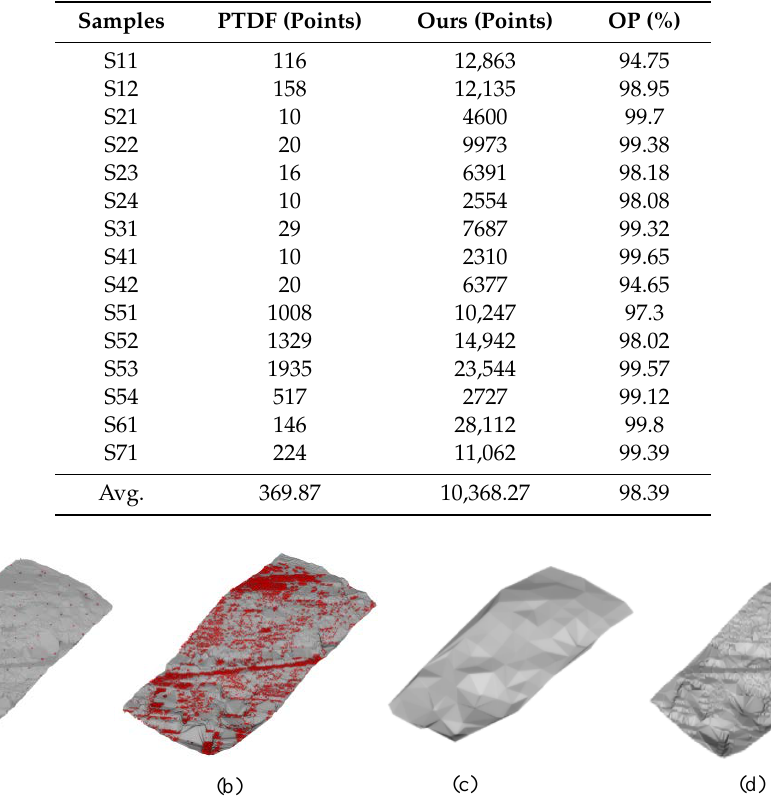
Table 4. Number and OP (overall precision) of ground seed points.